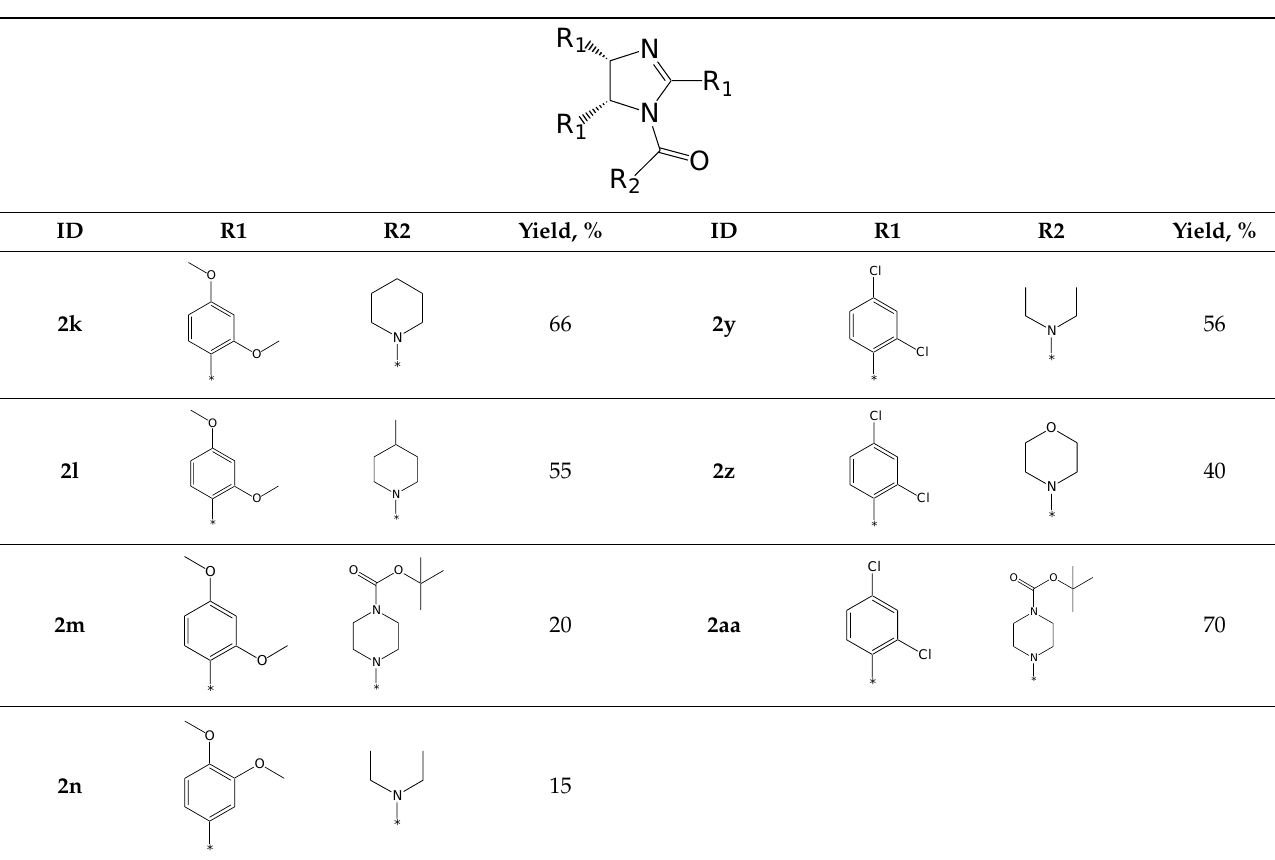
Figure 1. ( A ). The structures of novel p53-MDM2 interaction inhibitors 2l and 2k and known refer- ence molecules Nutlin-3a (1) and RG7112 (3). ( B ). The principal synthesis approaches for nutlin de- rivatives. ( C ). The described approach for the synthesis of RG7112 [10]. ( D ). The developed ap- proach. Table 1. Cont. Table 1. Synthesized 2,4,5-triaryl cis-imidazoline